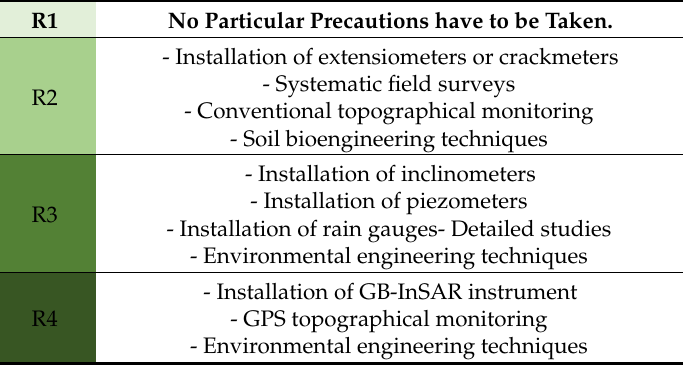
Table 3. Suggestions and actions that should be taken for each class of Risk (R). R1 No Particular Precautions have to be